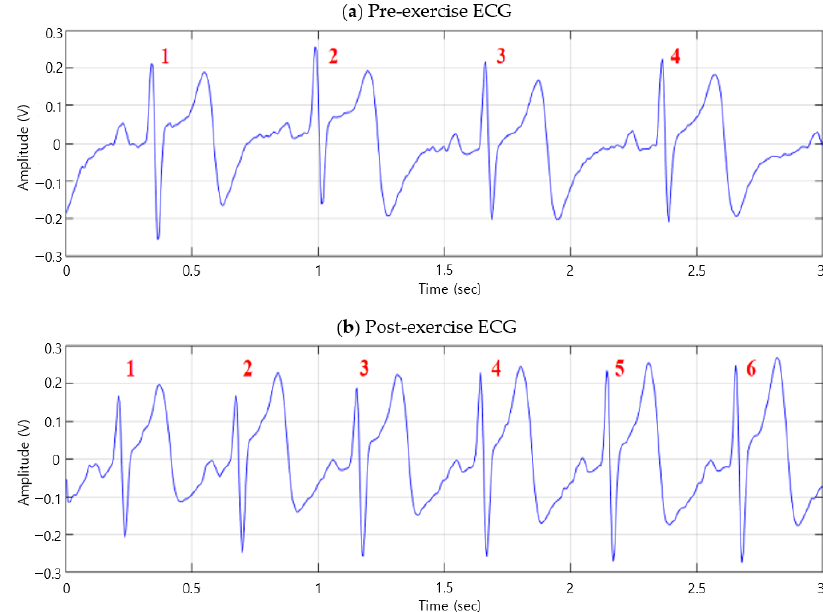
Figure 3. ( a ) Pre-exercise ECG ( b ) Post-exercise ECG.